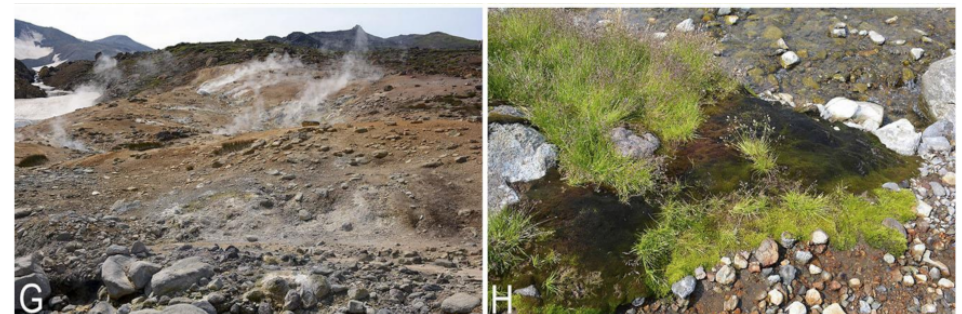
Figure 4. The foot of N-facing slope of Mutnovskaya Sopka Volcano, watershed between Osvistan- naya River and Falshivaya River, 1173 m a.s.l.: ( A ) dwarf shrub-lichen-moss tundra, view of the Otkhodyaschy Range; ( B ) solifluction spots with scattered patches of dwarf shrub-lichen tundra. ( C ) view of the Sopka Dvugorbaya Mt. and sulfurous thermal fields from the Otkhodyaschy Range, 1559 m a.s.l.; ( D ) dwarf shrub-lichen tundra and solifluction spots, dark patches are formed by Nardia braidlerii , 1209 m a.s.l. The foot of N-facing slope of Mutnovskaya Sopka Volcano, Falshivaya River basin: ( E ) upper reaches of small stream, a habitat for Lophozia , Scapania and Marsupella , 1185 m a.s.l.; ( F ) stream bank, Schistochilopsis and Pseudolophozia are occurring here, 1173 m a.s.l.; ( G ) sulfurous thermal field, 1095 m a.s.l.; ( H ) dark patch is formed by Plectocolea vulcanicola framing the sulfurous thermal field, 1095 m a.s.l. (Photo by K.G. Klimova, 2021).